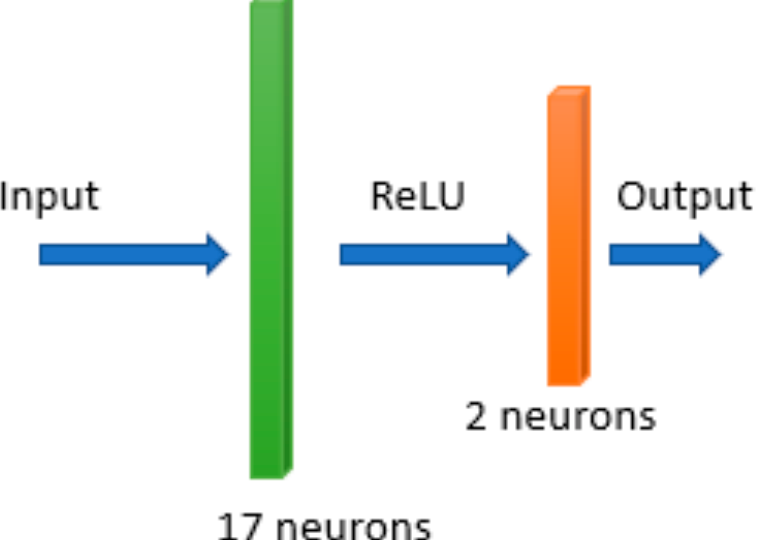
Figure 3. Architecture of the implemented neural